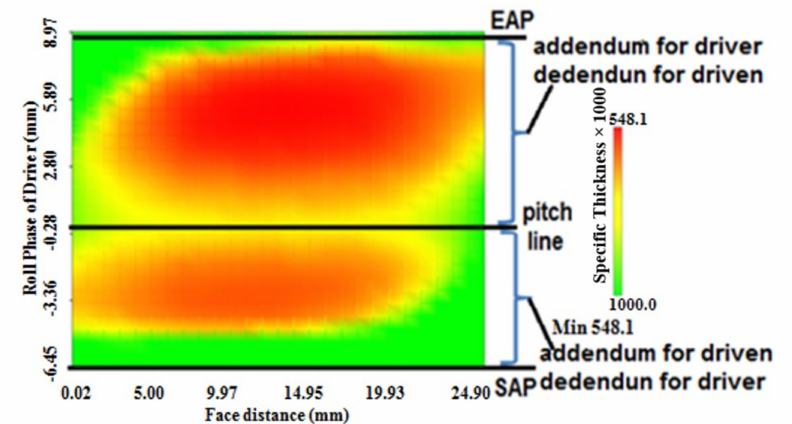
Figure 4. Example of specific film thickness determined by